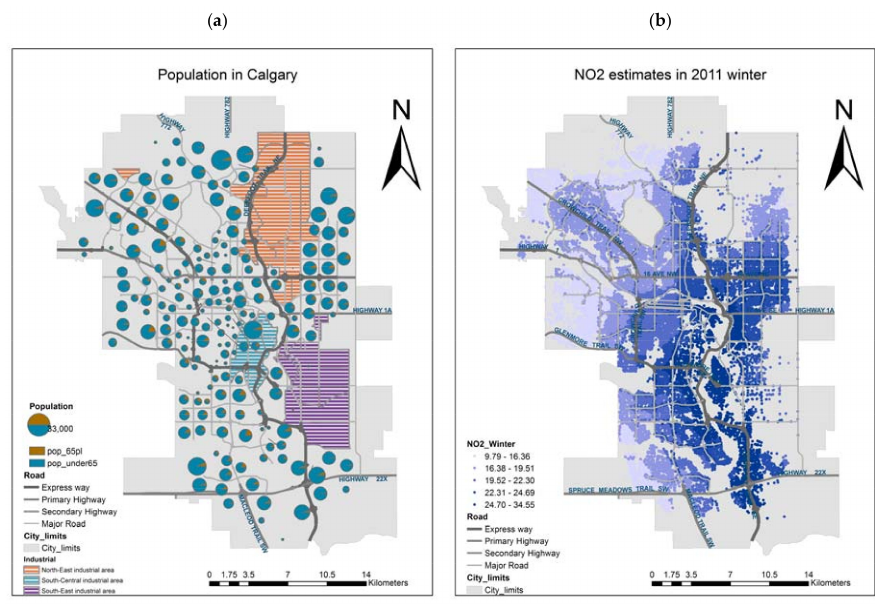
Figure 1. Population distribution ( a ), and air pollution ( b ) in